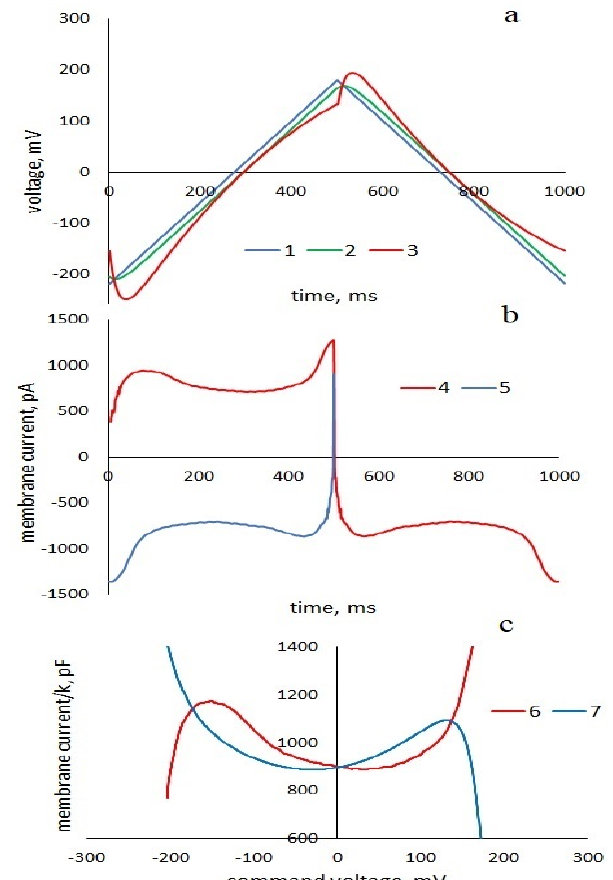
Figure 1. ( a ): 1—command triangular voltage with a frequency of 1 Hz and an amplitude of 200 mV; 2—voltage (cid:102) U 0 , calculated by Formulas (S9) and (S10), proportional to the input signal; 3—nonlinear